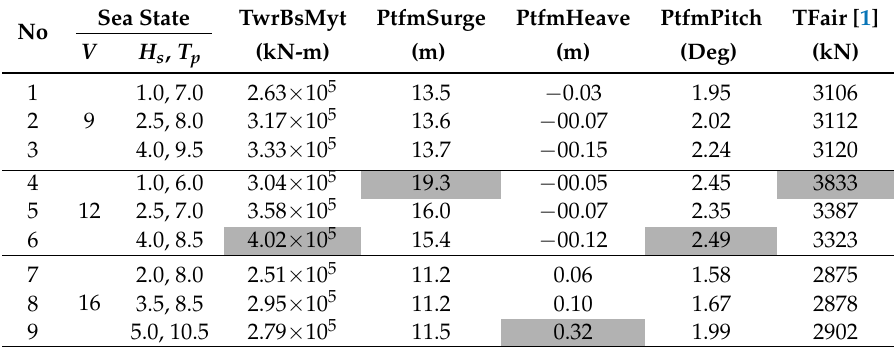
Table 12. Maximum values of the steady-state response of the integrated